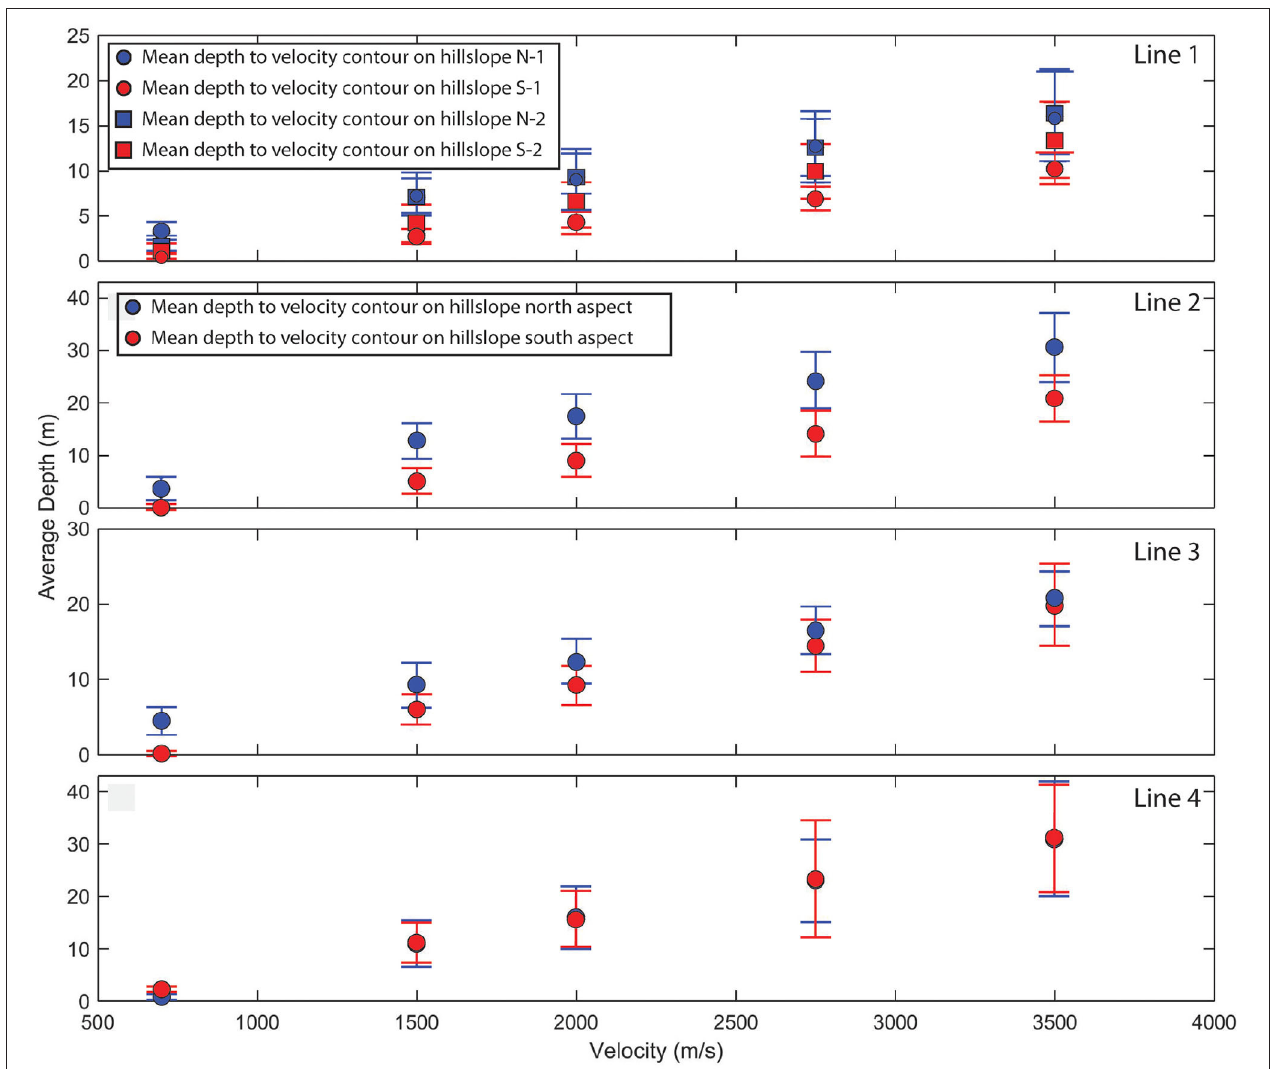
FIGURE 9 | Mean depth and standard deviation of the mean of various velocity contours for the north and south facing aspects, shown in blue and red, for each velocity profile. The 700, 2,000, and 3,500 m/s velocities correspond to the depth to top of saprolite, fractured bedrock, and fresh bedrock, respectively. In every line except Line 4 the mean depth of all velocity contours is greater on the north-facing slope and the depths to fractured